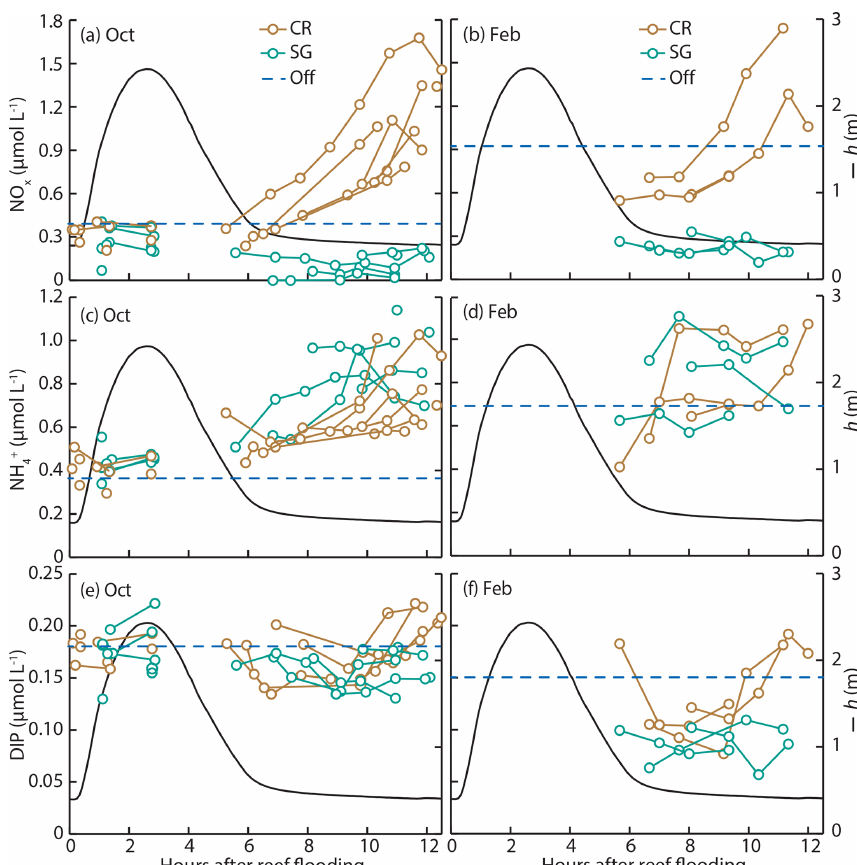
Figure 3. Measurements of (a, b) nitrate (NO x ), (c, d) ammonium (NH + ), and (e, f) dissolved inorganic phosphorus (DIP) from water 4 samples during October (a, c, e) and February (b, d, f) field experiments. Samples were taken at two reef stations; CR- and SG-dominated zones and mean offshore nutrient concentrations are shown (dashed blue line). Tidal phase-averaged water depth h is also shown (black